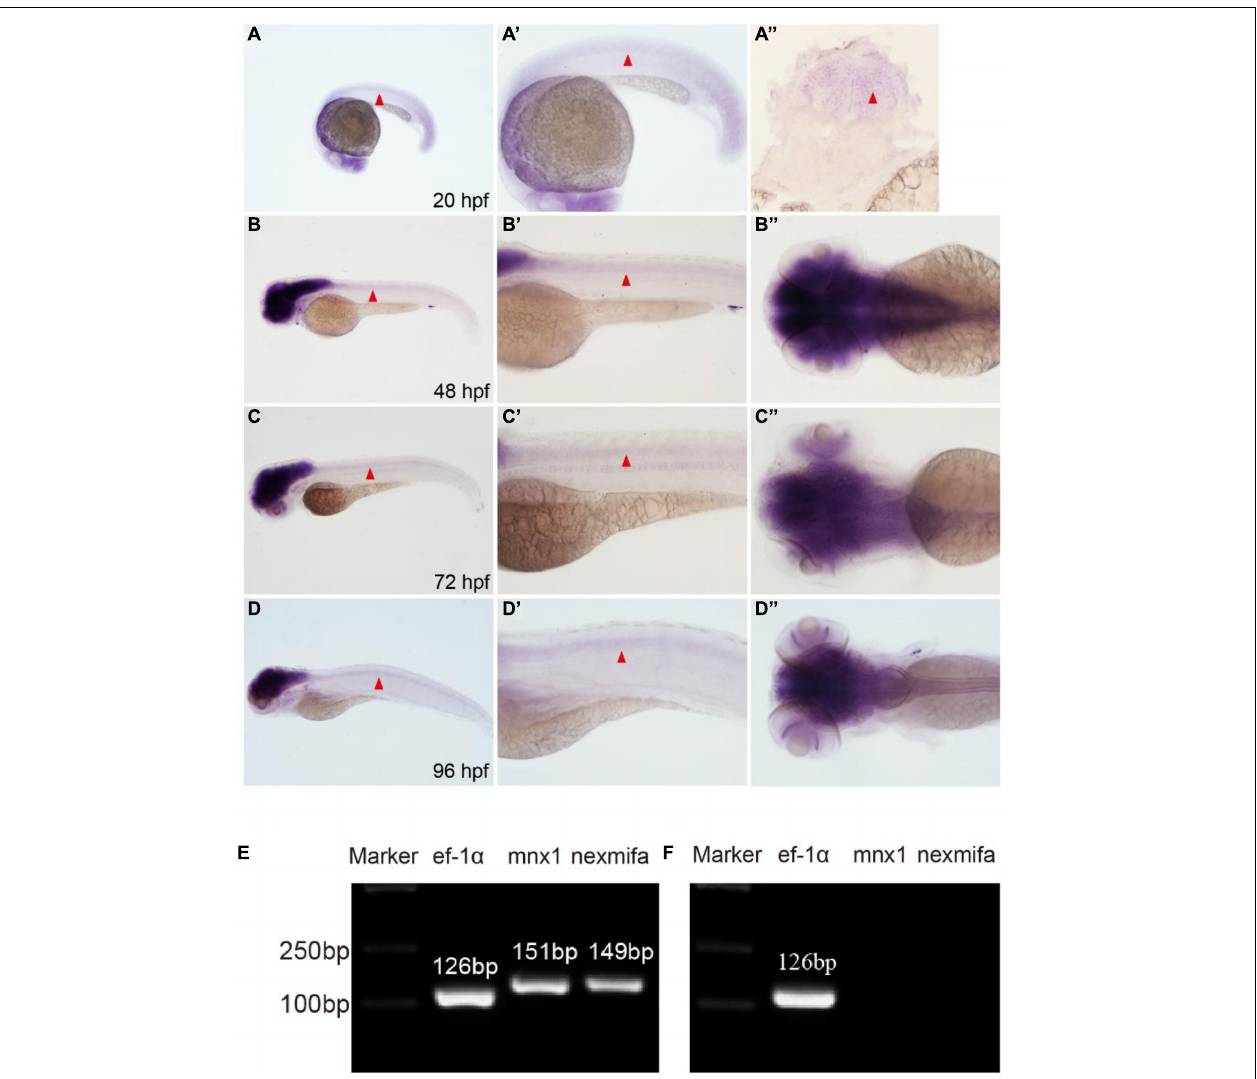
FIGURE 1 | Nexmifa expression analysis in spinal cord and motor neurons. (A) At 20 hpf, in situ hybridization nexmifa signals are localized in brain and spinal cord (lateral view). (A’) Partially magnified image of (A) . (A”) The trunk transverse section of the embryo. (B) At 48 hpf, in situ hybridization nexmifa signals are localized in the brain and spinal cord (lateral view). (B’) Partially magnified image of (B) . (B”) Dorsal view of the brain. (C) At 72 hpf, in situ hybridization nexmifa signals are localized in the brain and spinal cord (lateral view). (C’) Partially magnified image of (C) . (C”) Dorsal view of the brain. (D) At 96 hpf, in situ hybridization nexmifa signals are localized in the brain and spinal cord (lateral view). (D’) Partially magnified image of (D) . (D”) Dorsal view of the brain. (E) RT-PCR results on mnx1-GFP sorted cells. Nexmifa is expressed in selected neuron cells from the Tg (mnx1: EGFP) line. (F) The result of the RT-PCR on Kdrl-EGFP sorted cells. No signals of nexmifa and mnx1 are detected in the GFP-positive cells sorted from the Tg(kdrl:EGFP) line.